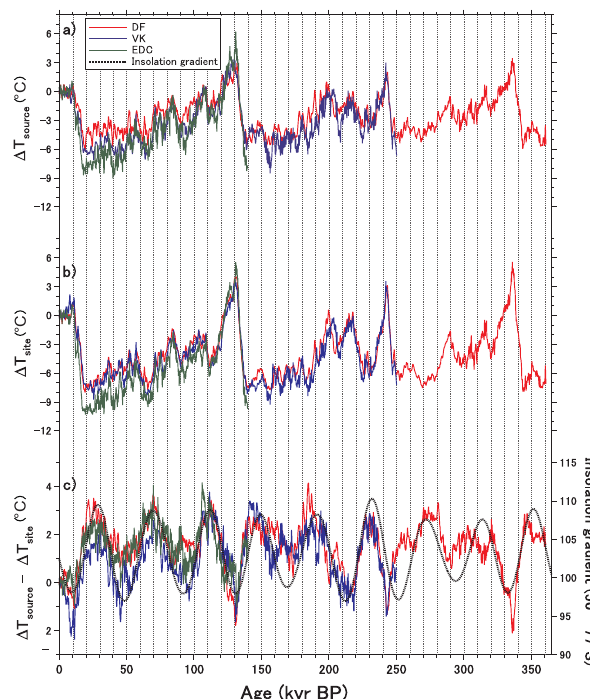
Fig. 7. The 1T site , 1T source , and the temperature gradient derived from the three cores. Temperature records reconstructed from the DF (red line), Vostok (blue line), and EDC (green line) cores using the isotope-fitting method. (a) 1T source , (b) 1T site , (c) Temperature gradient ( = 1T source − 1T site ) and annual mean insolation gradient between 50 and 77 ◦ S (Wm − 2 , black dotted